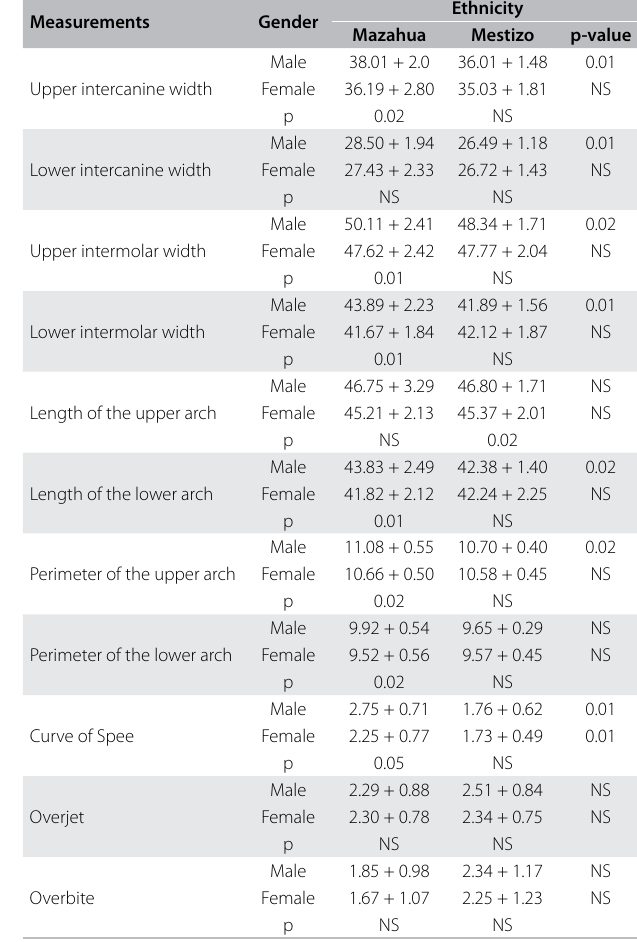
Table 2. Comparison of the dental arches between Mazahuas and mestizos by genders (15-17 years old)